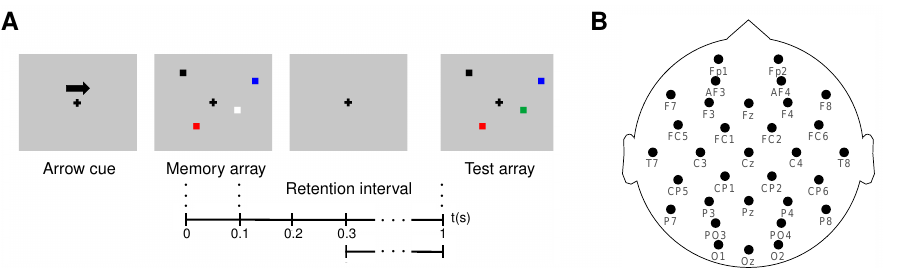
Figure 3. ( A ) Graphical representation of the change detection task for WM. ( B ) EEG channels selected from the montage used for the acquisition of the WM